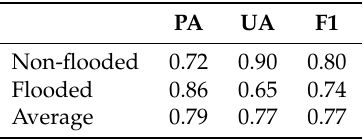
Table 4. Classification